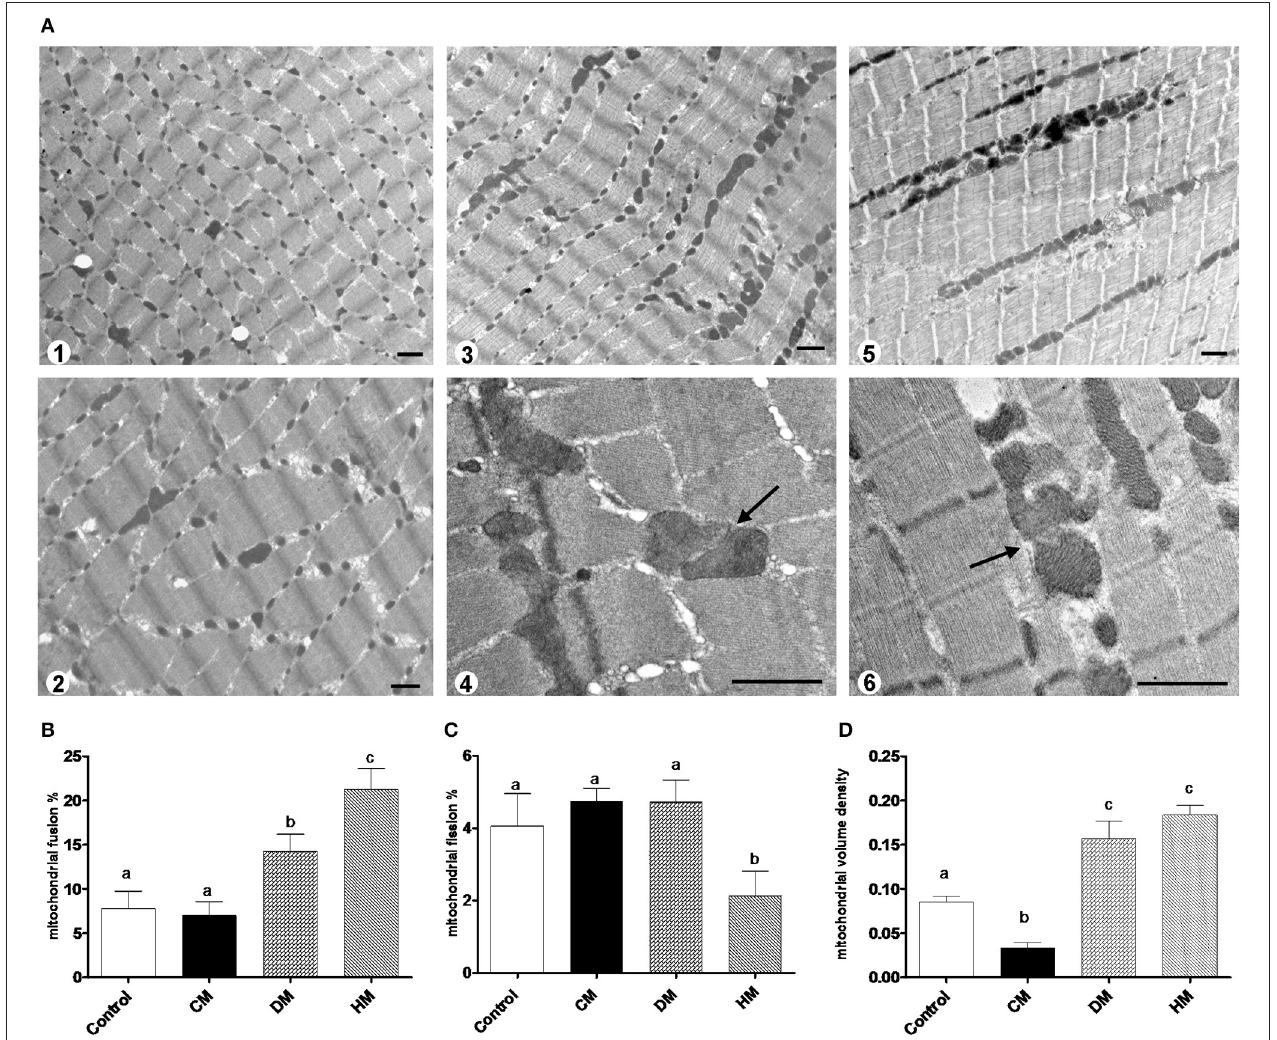
FIGURE 7 | Mitochondrial morphology and dynamics. The photomicrographs are the transmission electron microscopic images of the soleus muscles taken from the control (A1) , CM (A2) , DM (A3,4) , and HM-treated animals (A5,6) . Mitochondrial fusion was observed more frequently in the samples of DM (A3,4) and HM animals (A5,6) . Arrows indicate the fusion points. Scale bars, 1 µ m. Mitochondrial fusion and fission are quantified as percentage of mitochondria undergoing fusion (B) and fission (C) in reference to the total number of the mitochondria in the visual field. (D) Mitochondrial volume density. Data are presented as means ± SEM from n = 7 animals/group. Labeled means without a common letter differ ( P <